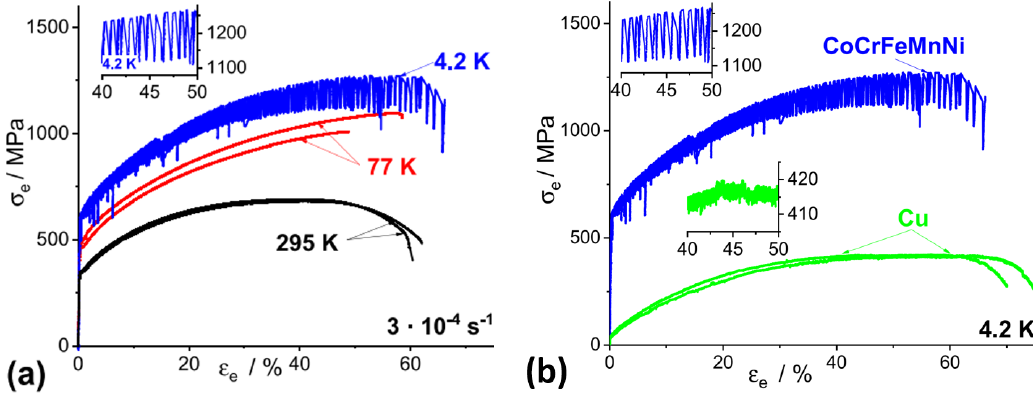
Figure 40. The stress–strain curves for the ( a ) CoCrFeMnNi HEA under tensile load at RT, 77, and 4.2 K. ( b ) CoCrFeMnNi HEA and pure Cu at 4.2 K (reproduced from Reference [299] with permission).